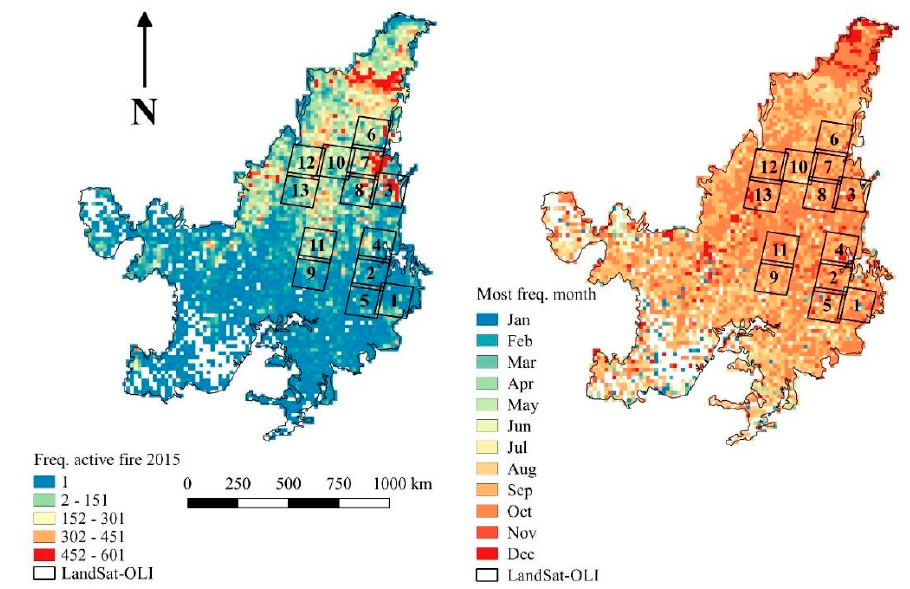
Figure 2. The frequency of Visible Infrared Imaging Radiometer Suite (VIIRS) active fires ( left panel ) and monthly active fires frequency ( right panel ) during 2015 Landsat 8 Operational Land Imager (LandSat-OLI) scene frames are also shown ( black squares ); numbers inside each square are depicted in Table 1.